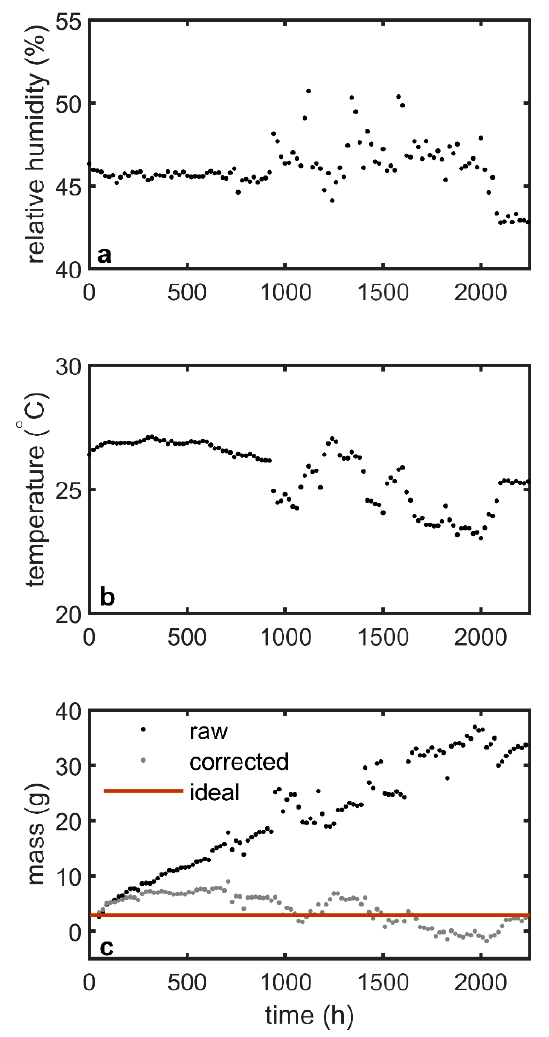
Figure A1. Laboratory conditions ( a , b ) during constant mass experiment, with raw mass and corrected mass ( c ).